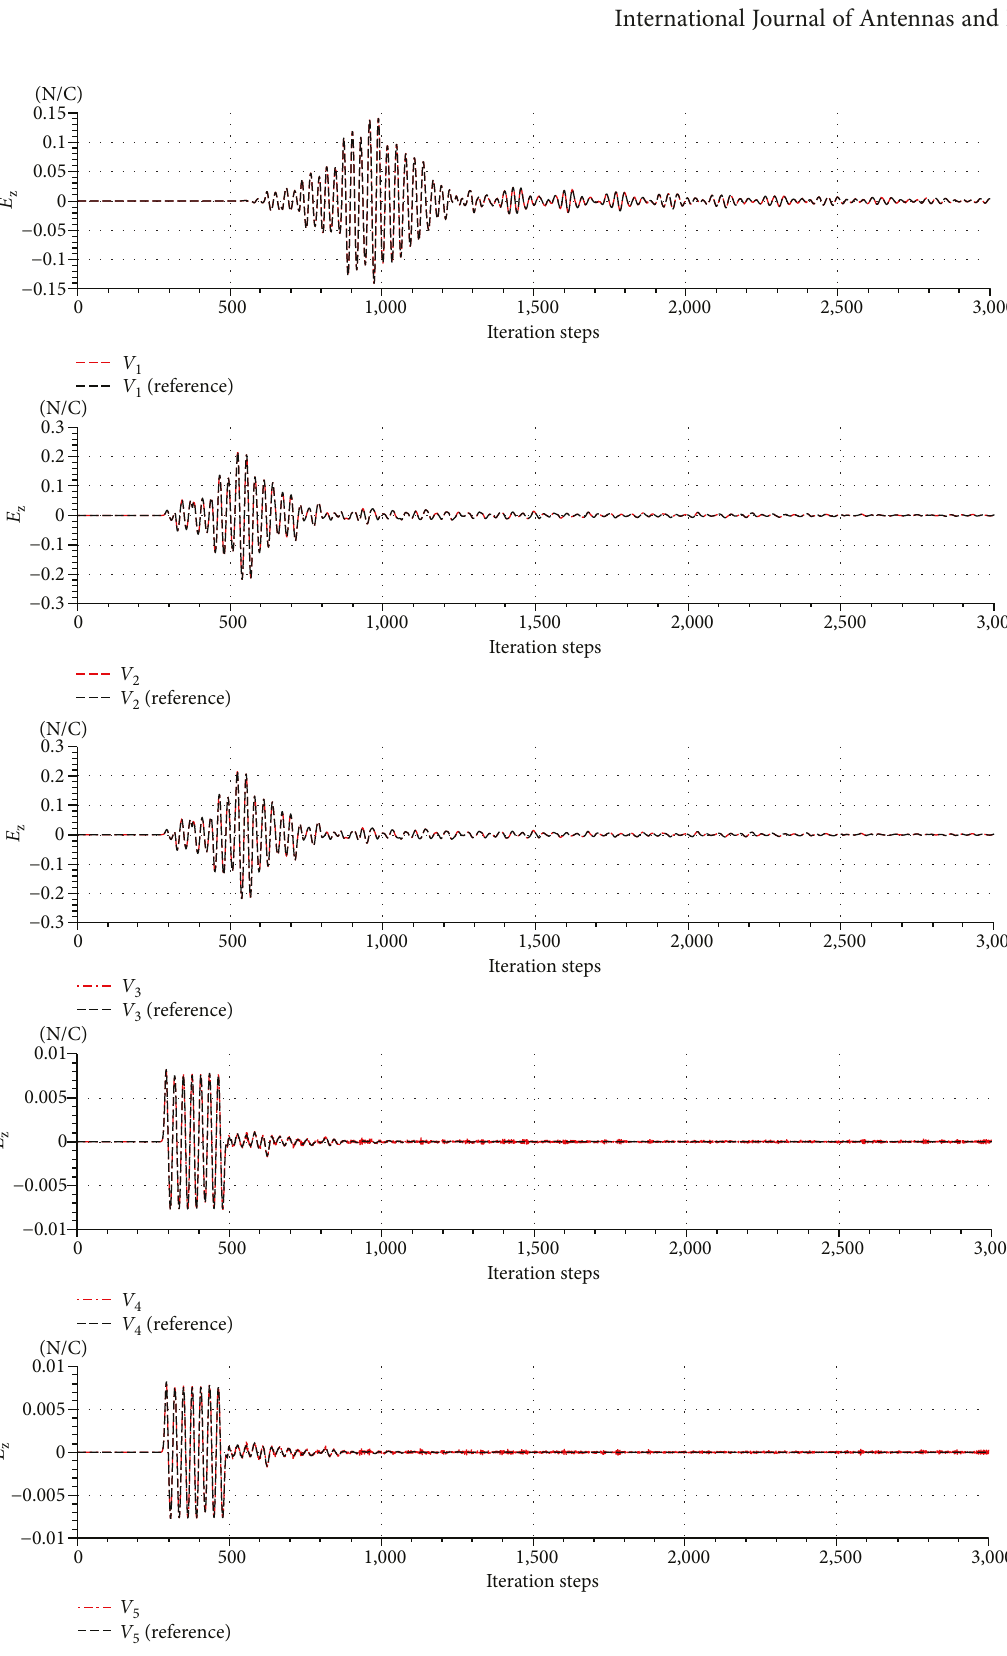
Figure 15: Behaviour of electric fi eld in the viewers of interest. No di ff erences between the values of the viewers of both the reference and the CPML solutions can be observed. When turning o ff the source ( n = 580 ), the CPML ABC adequately absorbs arriving